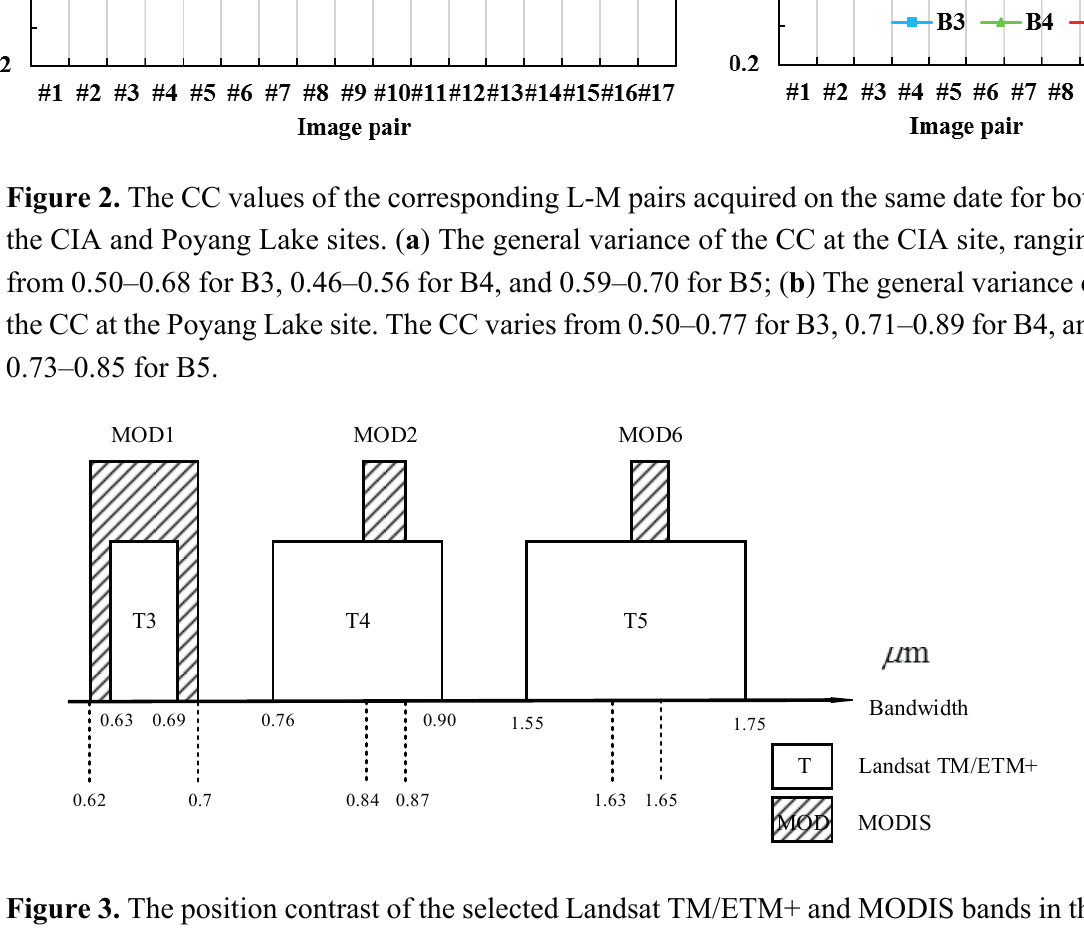
Figure 3. The position contrast of the selected Landsat TM/ETM+ and MODIS bands in the electromagnetic